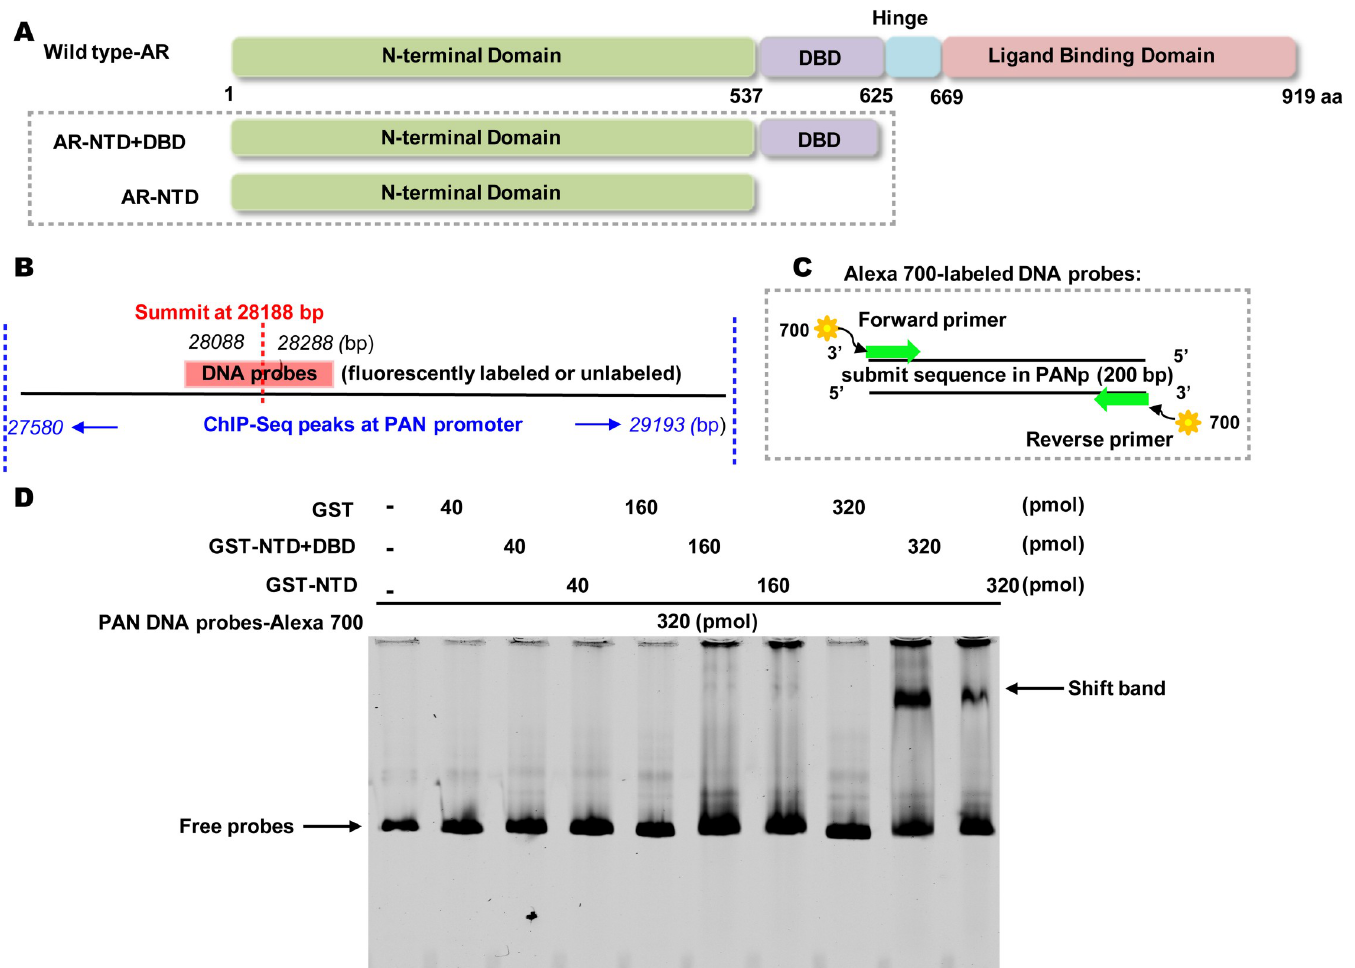
Fig 4. AR interacted with the PAN promoter majorly through its DNA-binding domain. (A) Illustration of AR functional structure and truncated constructs used in this study. (B) Illustration of fluorescence-labeled DNA probes used in the EMSA assay, spanning from 28,088 to 28,288 bp of PAN promoter. The fragment covered the summit at 28,188 bp in the ChIP peak on the PAN promoter as identified from deep sequencing. (C) Alexa Fluor 700 dye was used to label the 5’ terminus of the primers. (D) Two fusion proteins of AR both formed complexes with the PAN promoter, while the mutant lacked the DBD domain. Equal amounts of 320 pmol of DNA probe were used in each group. It was incubated with increasing amounts of GST-fused AR truncations or GST alone. The two GST-fused AR truncations comprised an N- terminus with a DNA-binding domain of AR (GST-NTD+DBD) and a shorter version of GST-NTD, which lacked the DBD domain. GST protein alone was used as a negative control. The lane with only DNA probe was used to indicate the size of free probes. Representative images are shown. Each reaction was repeated in, at least, triplicate.